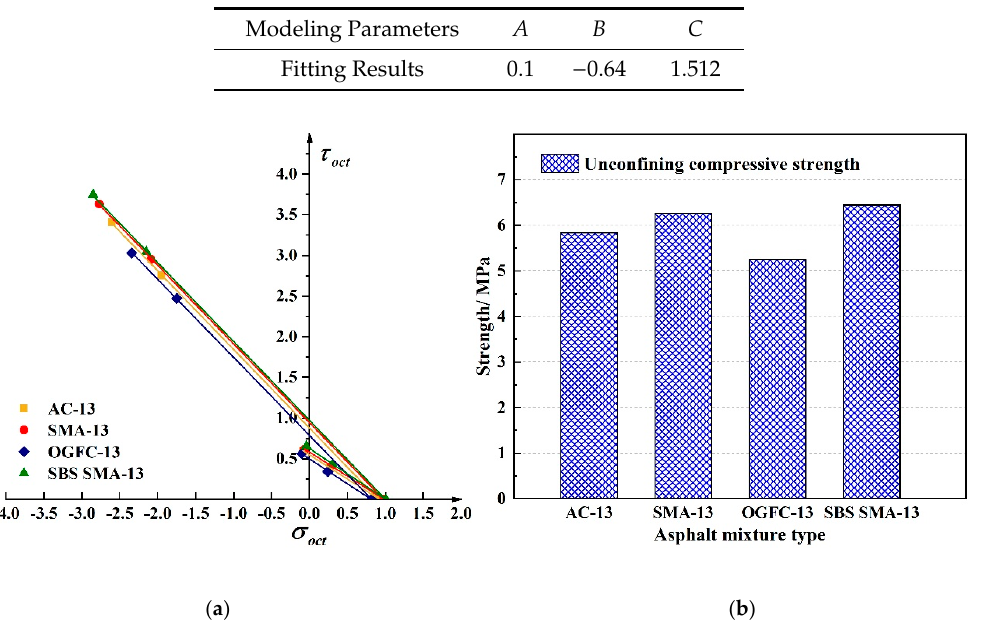
Figure 7. Linear compressive and tensile meridian under three type of gradation. ( a ) The compressive and tensile meridian under three type of gradation ( b ) The strength comparison between three type of gradation.